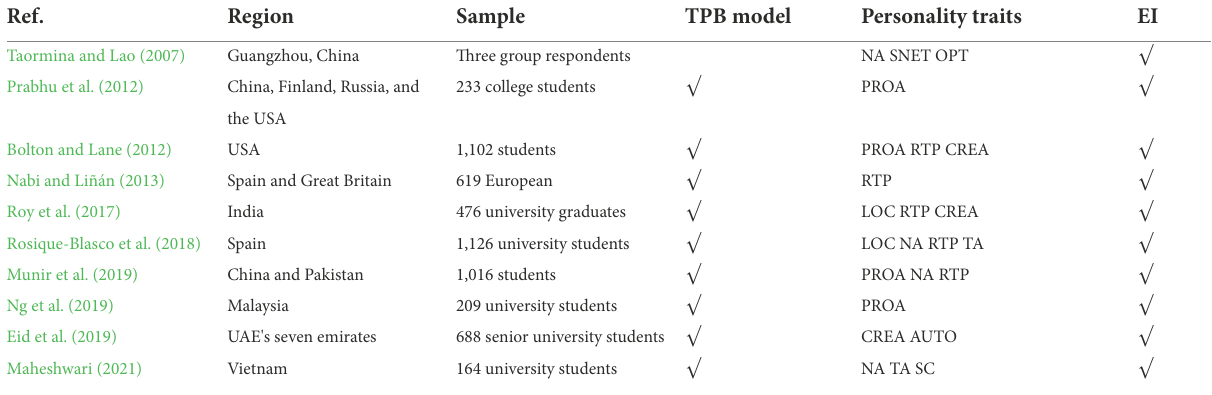
TABLE 1 Research on personality traits and entrepreneurial intention.